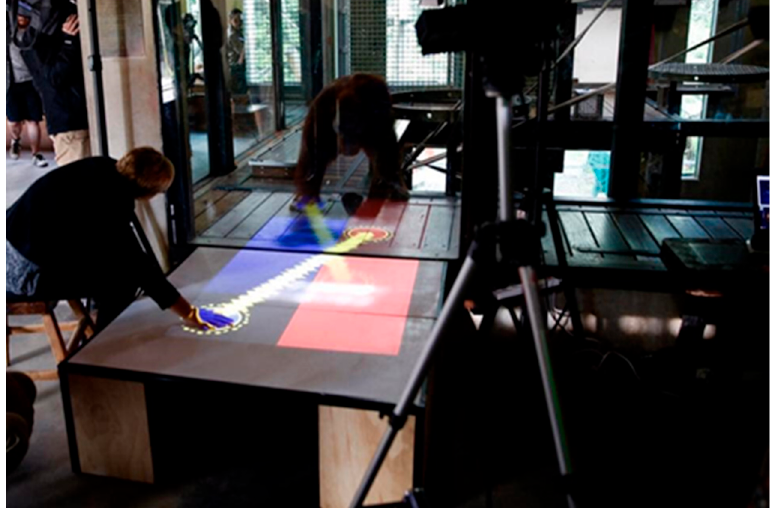
Figure 11. Prototype light game between orangutan and researcher at Melbourne Zoo (Photo: Zoos Victoria).